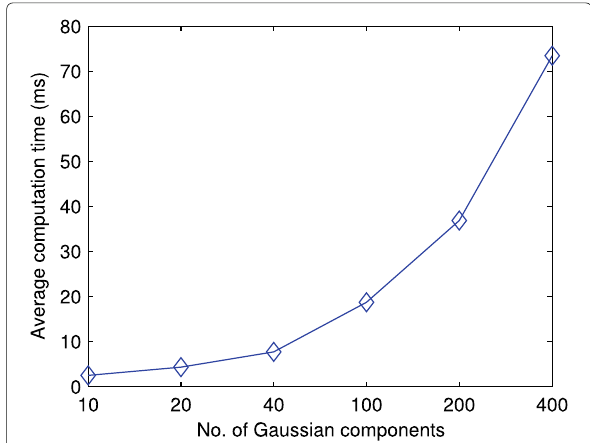
Fig. 5 Average computation time of the proposed noise estimation with different Gaussian numbers at 10 dB SNR in white noise